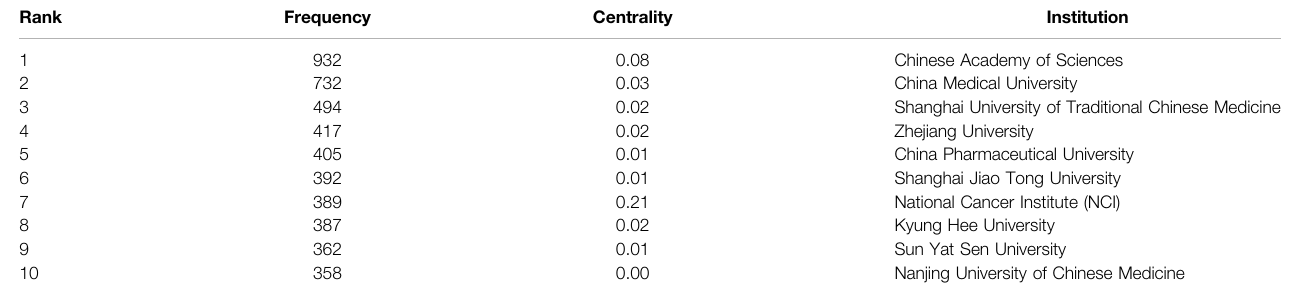
TABLE 4 | List of scienti fi c research institutions in the cooperation network of anticancer natural products. Rank